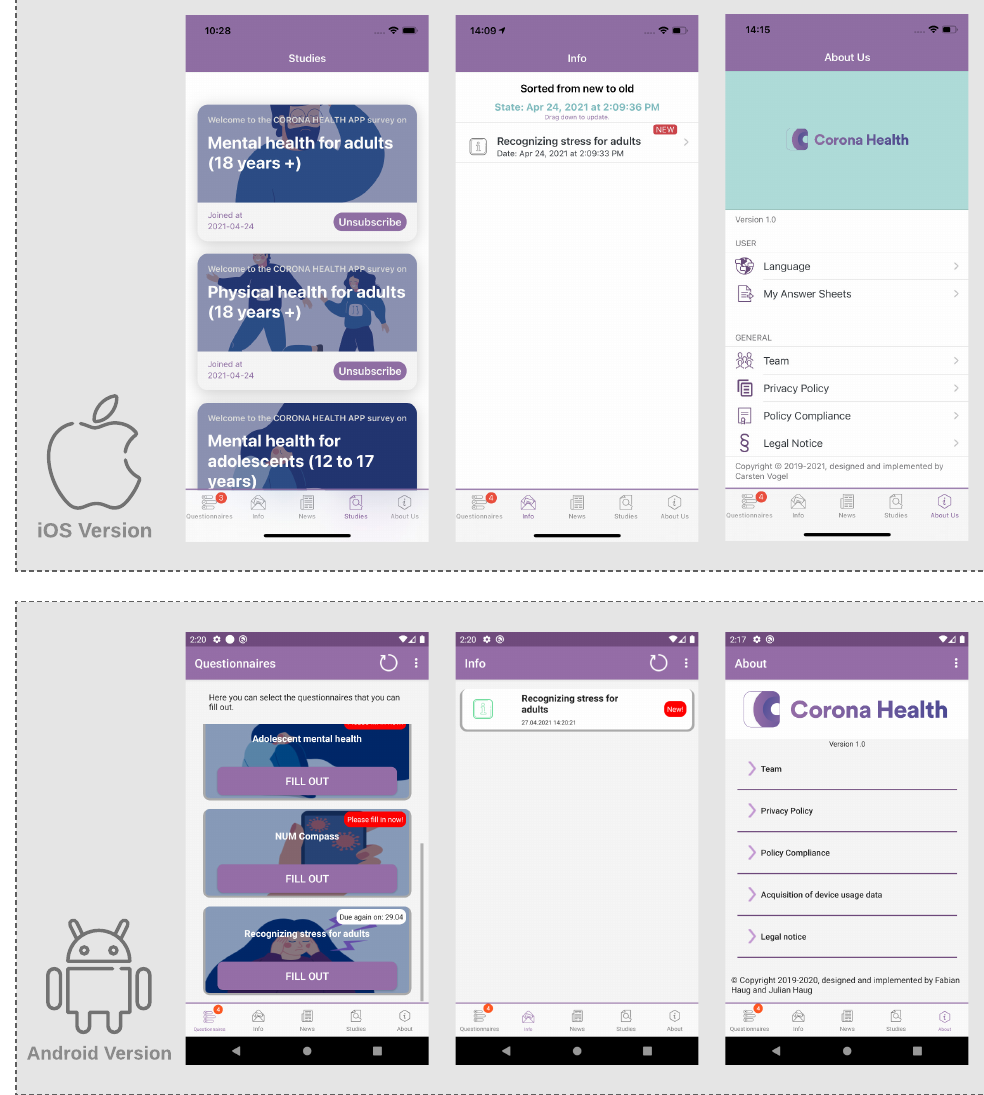
Figure 2. Screenshots of the iOS and Android versions of Corona